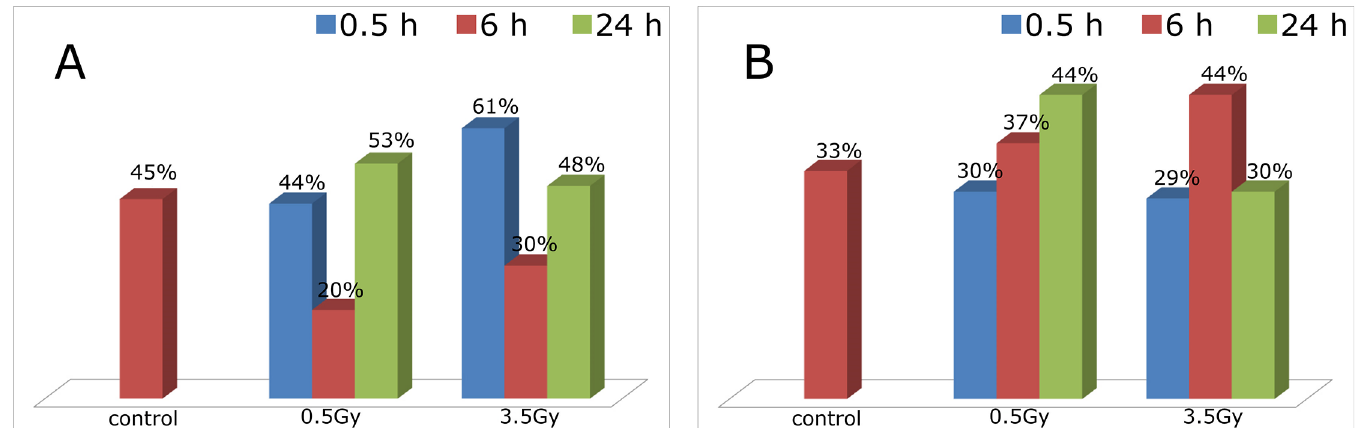
Fig 10. Cluster analysis of the spatial distribution of heterochromatin and euchromatin after irradiation with 0.5 Gy and 3.5 Gy. The analysis was performed on non-irradiated samples, and on samples fixed 6 h and 24 h post irradiation, respectively. Panel A present the behaviour of heterochromatic regions irradiated with 0.5 Gy and 3.5 Gy. We observe a decrease in the ratio of the clustered points 6 h after irradiation for both doses. 24 h after irradiation these changes are reverted. This means that a few hours after irradiation the heterochromatin decondenses and after one day the decondensation is reverted. Panel B shows the cluster analysis result for euchromatin. These regions behave differently, compared to heterochromatin. For 0.5 Gy, the number of clustered points is increased after 6 h, and the trend continues at the 24 h timestamp. However, for 3.5 Gy, after the initial increase in the percentage of clustered points at 6 h, the ratio drops again in the 24 h measurements. The interpretation of the increase/decrease in the number of clustered points is similar in this case: when the ratio increases, the studied domains condense, when the ratio decreases, the domains relax. This means, that heterochromatin and euchromatin react to irradiation in an opposite way: This analysis, in accordance with the other results, indicates that while heterochromatin opens up soon after irradiation, euchromatin condensates. Given enough time, these processes are reverted in both